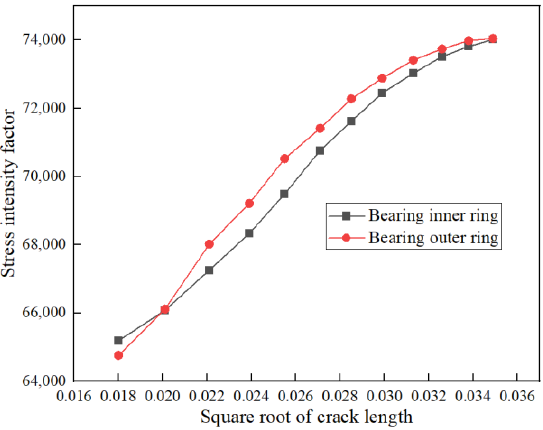
Figure 11. Relationship between K  and x at different positions.